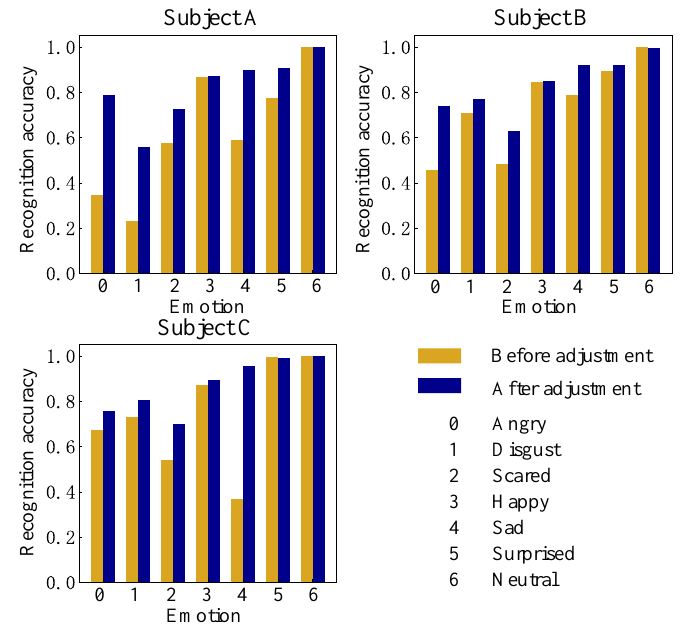
Figure 7. Comparison of various expression recognition tests.